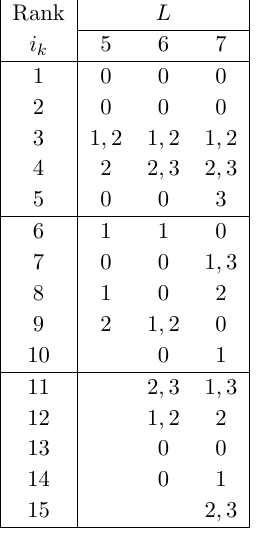
Table 8 . Momentum labels m (modulo L ) for the (cid:12)rst 15 eigenvalues in the Z 2 -even sector for the Ising model ( Q = 2). We have not been able to identify the labels i L for line 17 of the table.